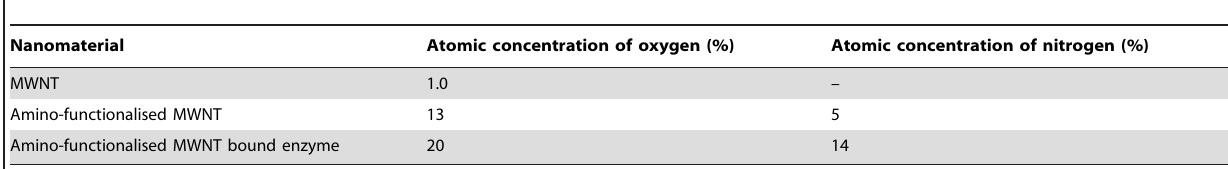
Table 1. Atomic concentrations of MWNT, amino-functionalised MWNT and amino-functionalised MWNT bound enzyme from XPS experimental data.